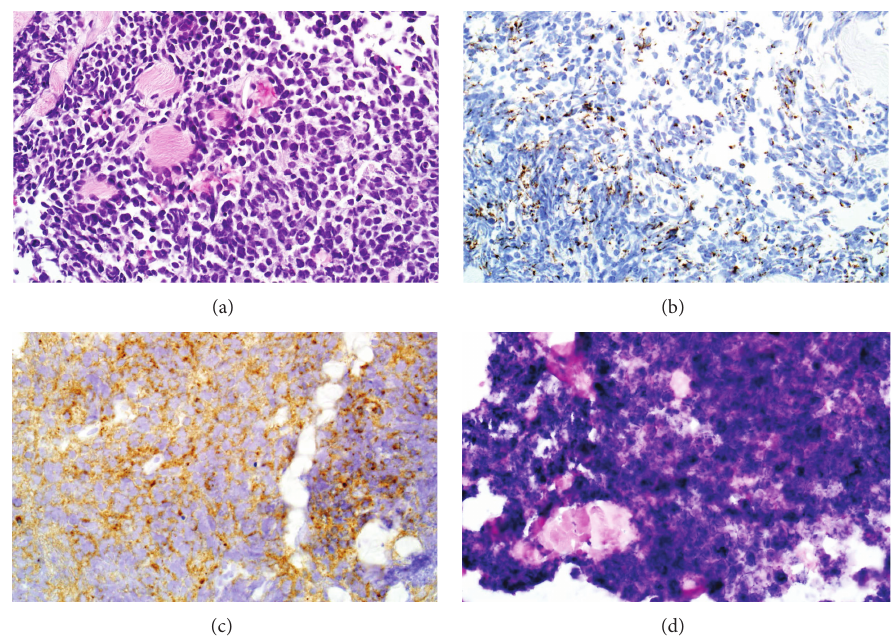
Figure 4: Hematoxylin and eosin staining showing nasal mass with small cell carcinoma (a), immunohistochemical staining showing tumor positivity for AE1/AE3 in a dot-like pattern (b), synaptophysin (c), and high-risk HPV by in situ hybridization (d). (a) The tumor consisted of a uniform population of small cells with minimal cytoplasm and hyperchromatic, angulated nuclei that demonstrated molding. The tumor exhibited high grade features including a high mitotic rate and necrosis (hematoxylin and eosin, × 400). (b) The neoplasm was positive for cytokeratin on a perinuclear, dot-like pattern (AE1/AE3 immunohistochemistry, × 400). (c) The tumor exhibited neuroendocrine differentiation in the form of diffuse staining for synaptophysin (synaptophysin immunohistochemistry, × 400). (d) HPV studies showed that the tumor harbored high-risk HPV DNA (high-risk HPV in situ hybridization, ×